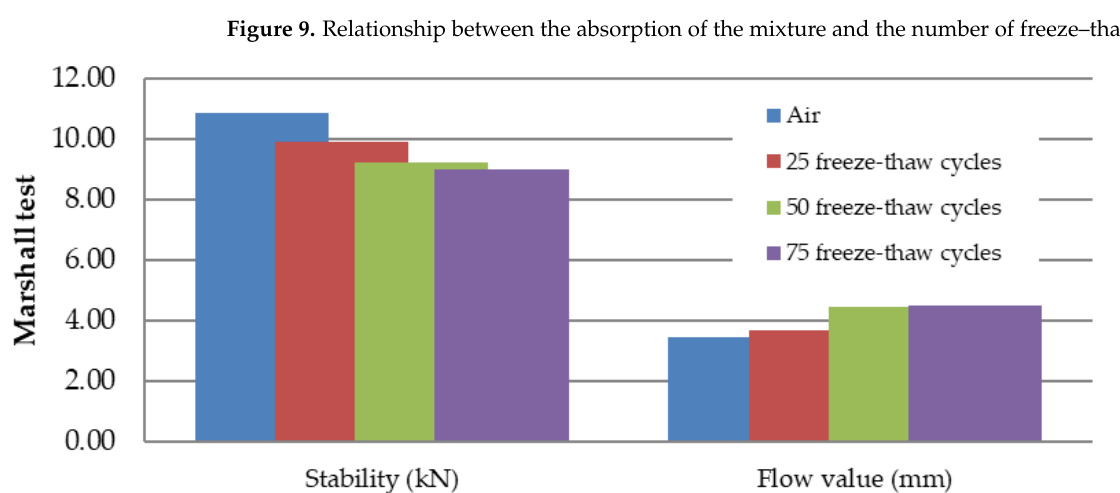
Figure 10. Marshall stability (kN) and flow value (mm) depending on the number of freeze–thaw cycles.